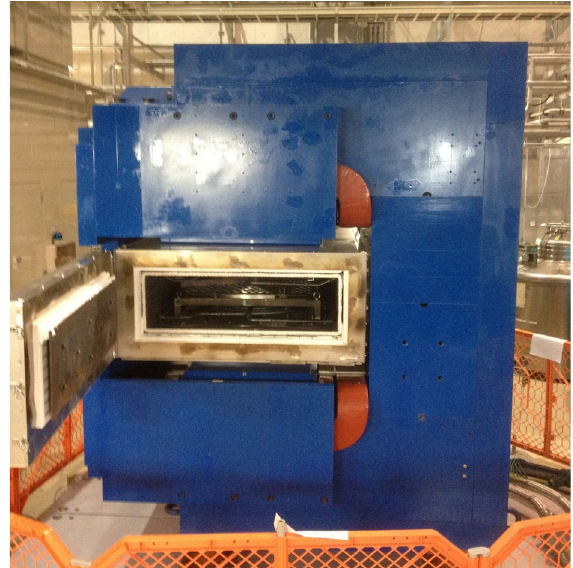
FIG. 11. The FT3L core production system using the Kappa magnet. The inner size of the oven is 1 : 1m ð W Þ(cid:2) 0 : 37m ð H Þ(cid:2) 1 : 4m ð L Þ to anneal the large size core up to 0.85 m diameter.